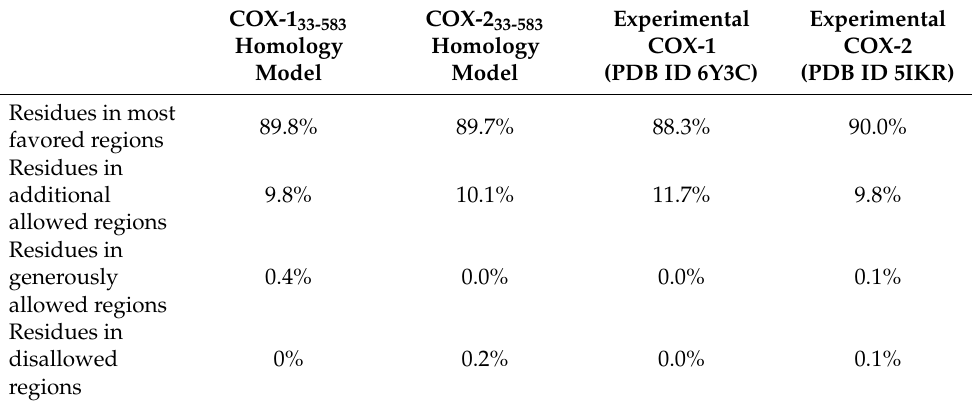
Table 1. Ramachandran plot results for COX-1 33-583 and COX-2 33-583 homology models. Results for COX-1 and COX-2 experimentally solved structures are shown as reference. Values were calculated with PROCHECK